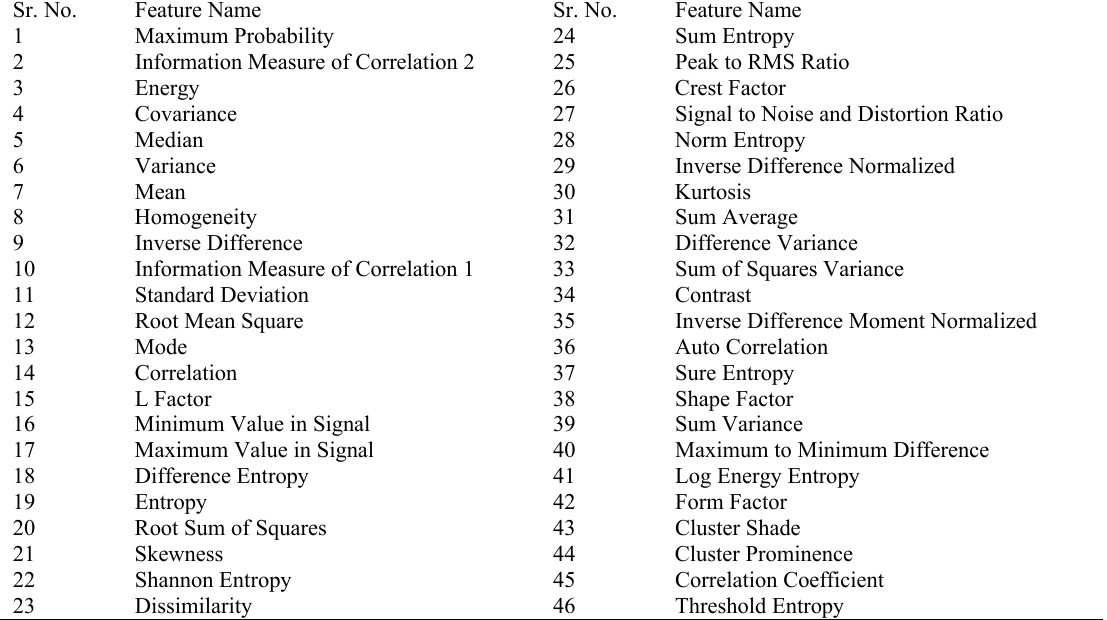
Table 2. Lasso Features Sr.